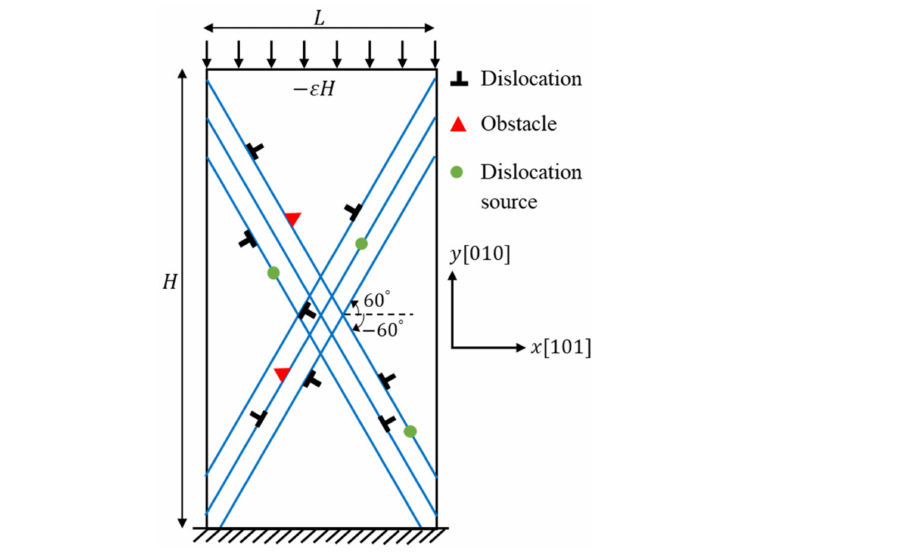
Figure 9. Sketch of micropillar compression. The black T-signs represent dislocations. The red triangle and green circle represent obstacle and source,